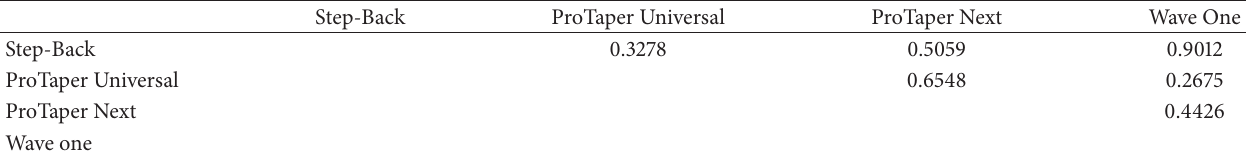
Table 2: Kruskal-Wallis test showed no statistically significant differences in the middle third ( 𝑝 > 0.05 ).